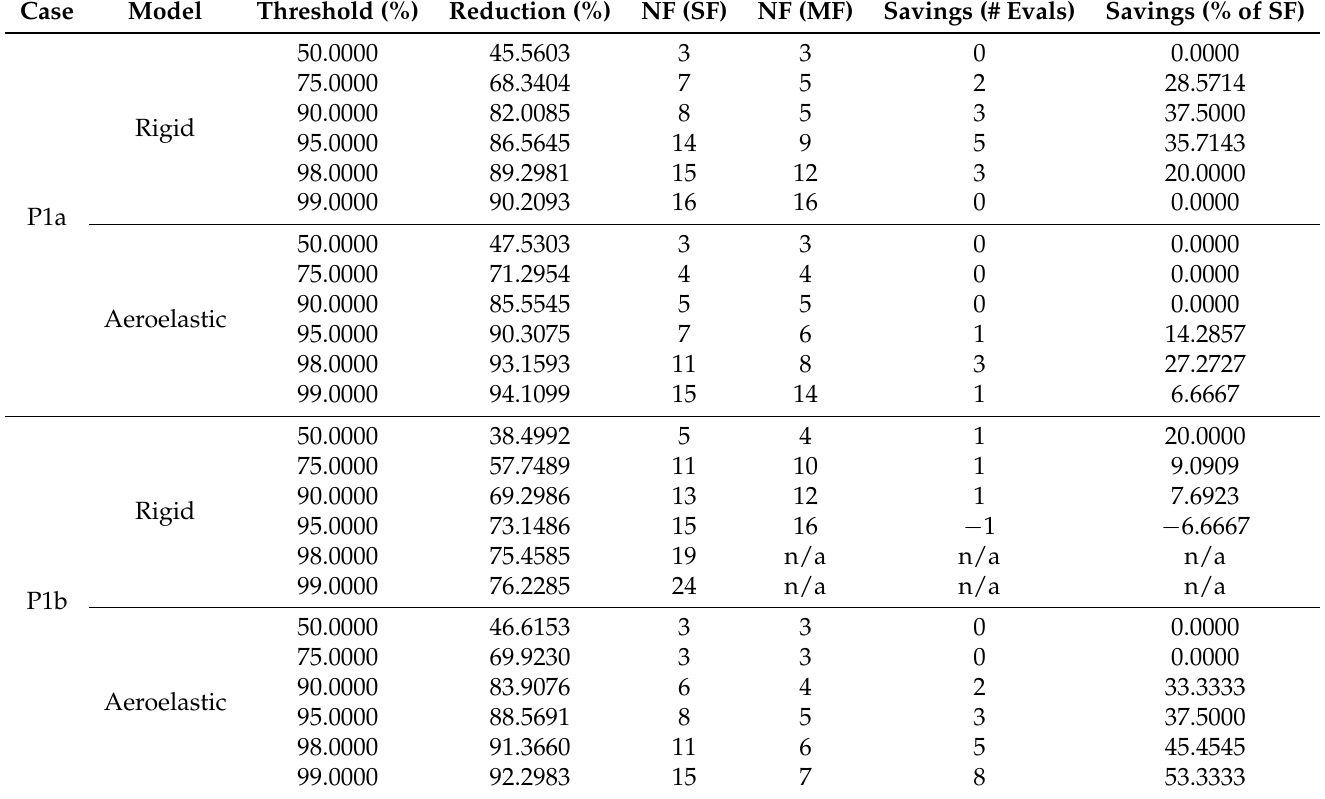
Table 9. Cost summary for airfoil optimization